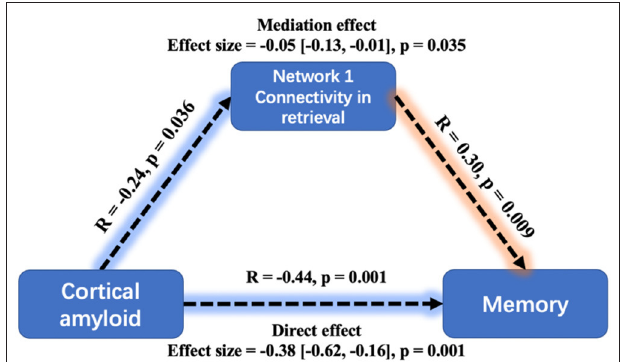
FIGURE 6 | Mediation analysis between cortical amyloid, task-related Network 1connectivity, and memory performance. A greater cortical amyloid deposition has a significant but indirect association with worse memory performance, mediated via the mean connectivity during retrieval within Network 1. Mediation effects were computed by 10,000 bootstrapped samples and the 95% confidence intervals were reported.